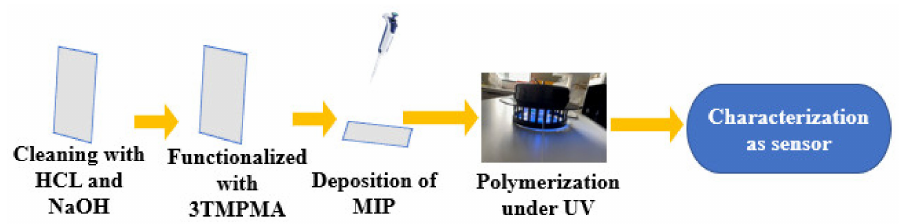
Figure 2. Schematic of sensor fabrication including surface functionalization and